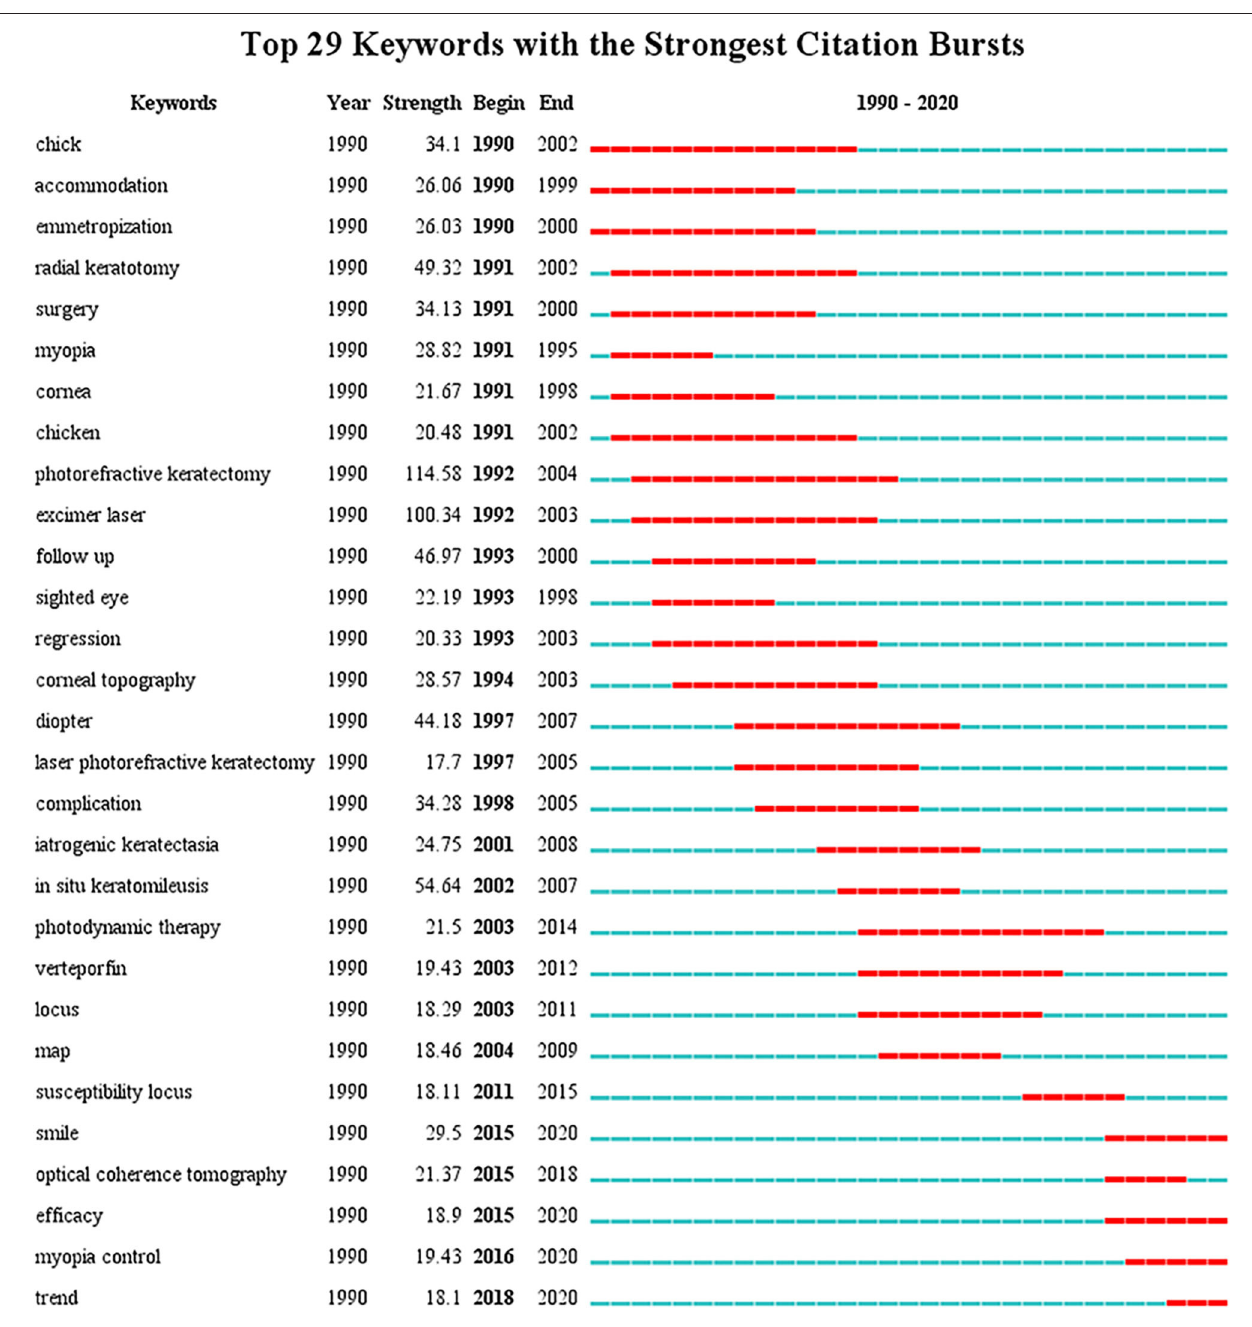
growth. According to the prevailing view, longer time spent outdoors can prevent myopia (28). The available data revealed that high-intensity outdoor light may act as a protective factor by adding retinal dopamine concentrations and thus preventing myopia